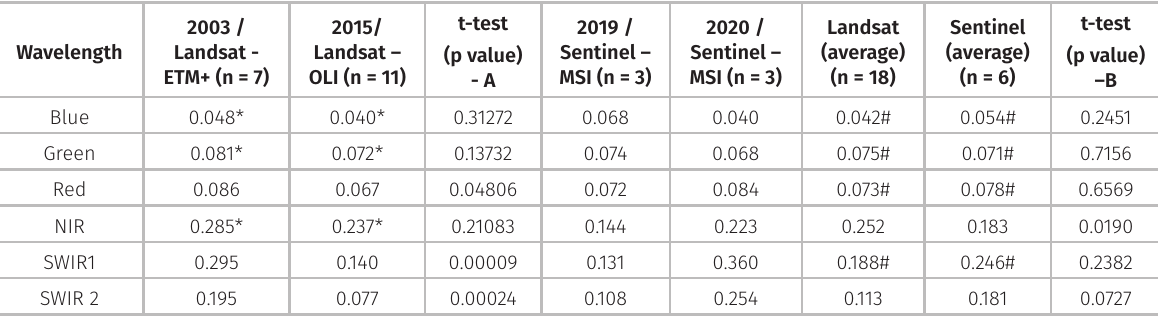
Landsat surface reflectance means following by * in the same wavelength have no statistical difference using 10% as minimum level of probability. Surface reflectance means following by # in the same wavelength for comparison between satellites have no statistical difference using 10% as minimum level of